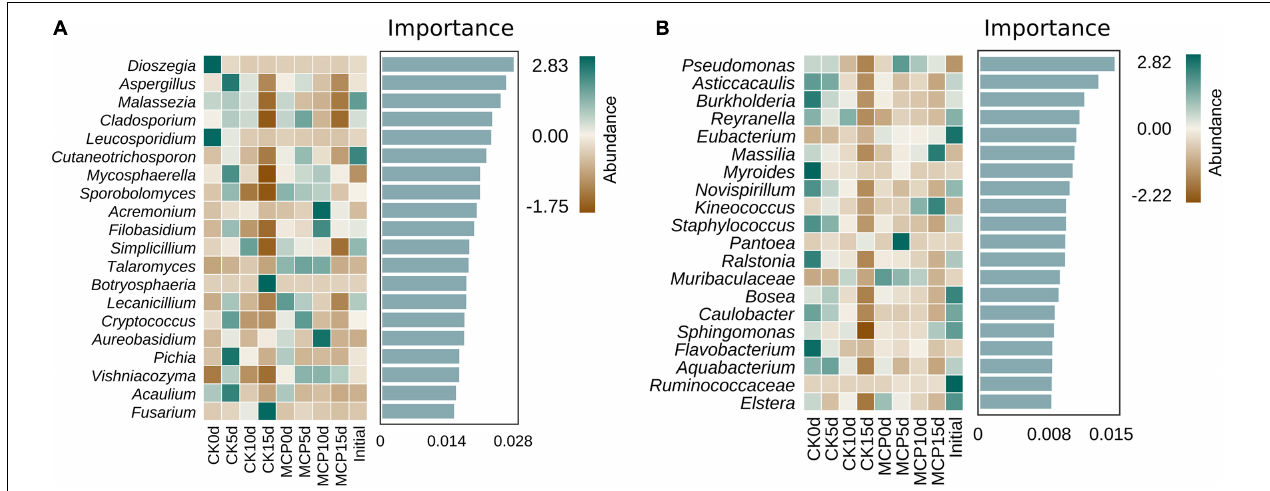
FIGURE 4 | Random forest analysis of fungi (A) and bacteria (B) in pear ( Pyrus communis L.cv. “Doyenne du Comice”) fruit after treatment with or without 1-MCP during storage. The horizontal axis of the histogram shows the importance of species to the classifier model, and the vertical axis is the taxon name of fungi or bacteria at the genus level. The heat map shows the abundance distribution of these genera in each group. Five-fold cross-validation was used. Results from the Random Forest analysis showed that Botryosphaeria and Fusarium were presumably the fungal biomarkers, and Massilia and Kineococcus were the bacterial biomarkers of CK15d, indicating that these organisms were critical in distinguishing between applications with or without 1-MCP treatment after 15 days of